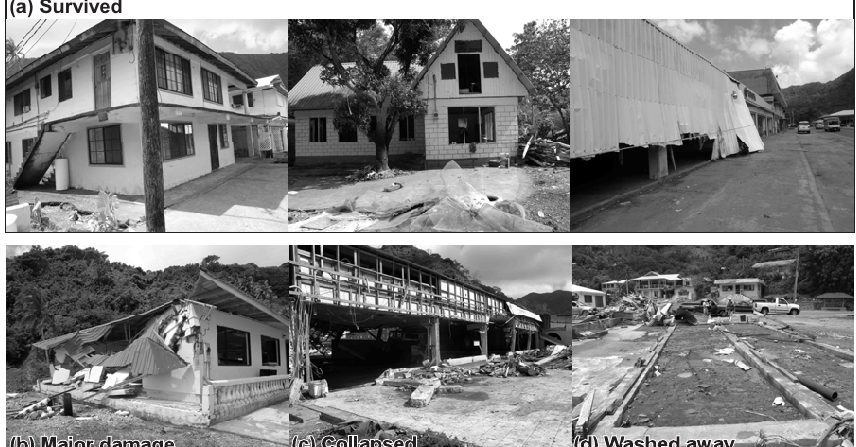
Figure 6. Classification criteria based on the field survey.